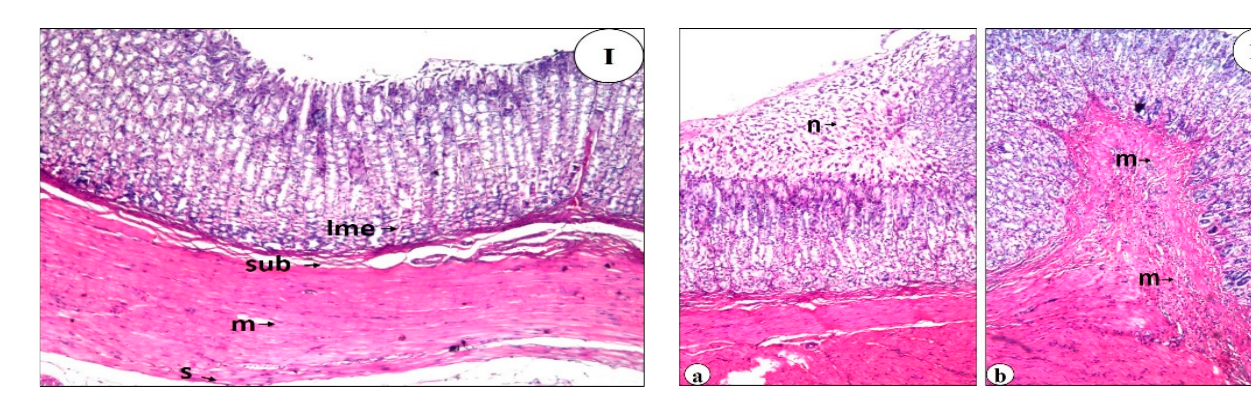
Figure 3. I. Showing a normal histological structure of the lining mucosal epithelium (lme) of the stomach with underlying glands and submucosa (sub), muscularis propria (m), and serosa (s) in the control rats group without any degenerative or necrotic changes. H&E ×